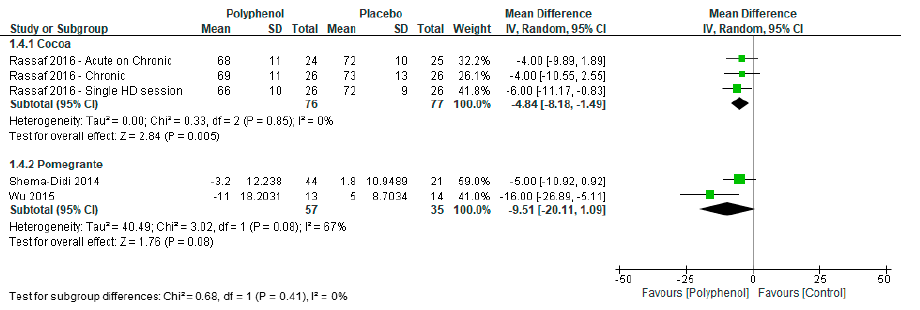
Figure 5. Forest plot of polyphenol-rich interventions on diastolic blood pressure.